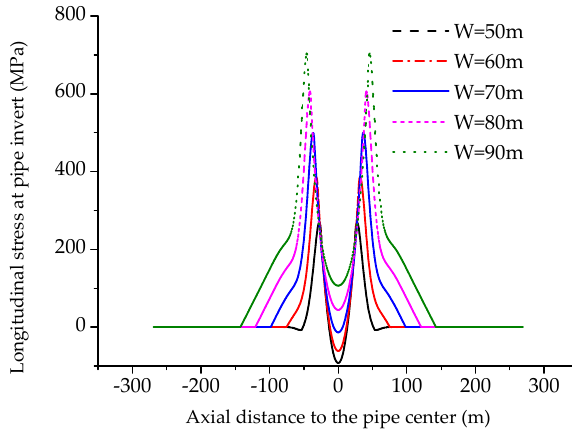
Figure 22. Longitudinal stresses at pipe invert for pipes with various wall thicknesses.